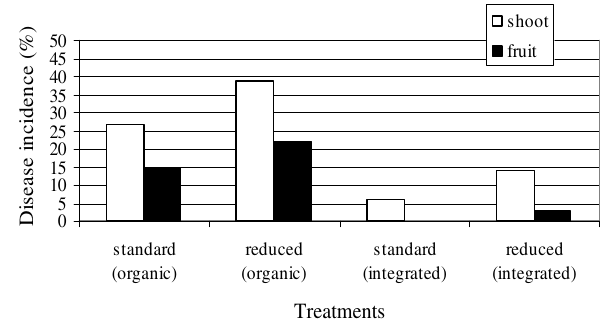
Figure 6. Efficacy of standard and reduced spray programmes on brown rot on shoot and fruit in integrated and organic sour cherry orchards in 2009 (LSD = 3.2 – integrated (shoot); LSD 0.05 = 5.2 – organic